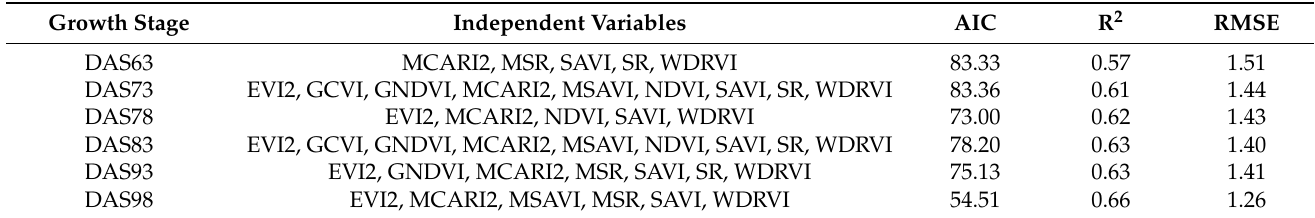
Table 5. The accuracy of Sentinel-based Yield-SMLR model in each growth period.